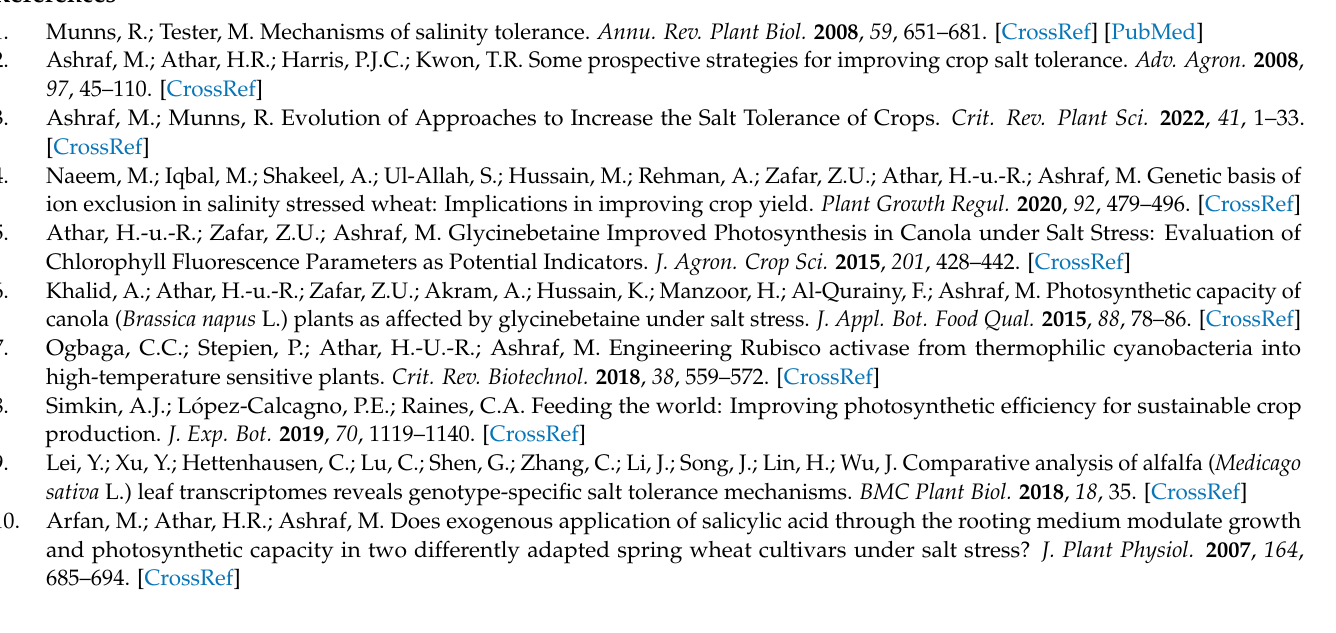
L. cultivar Oscar, Table S1a: Gene count data for RNASeq from Canola ( B. napus L.) plants grown under Control (0 mM NaCl) or Saline (200 mM NaCl) conditions, Table S1b: Fold Change (log2FC) for DEGs in Canola ( B. napus L.) plants grown under Control (0 mM NaCl) or Saline (200 mM NaCl) conditions, Table S2: List of number of DEGs in salt-sensitive canola cultivar Oscar when subjected to salt stress, Table S2a: List of selective up-regulated DEGs (Fold change > 5), Table S2b: List